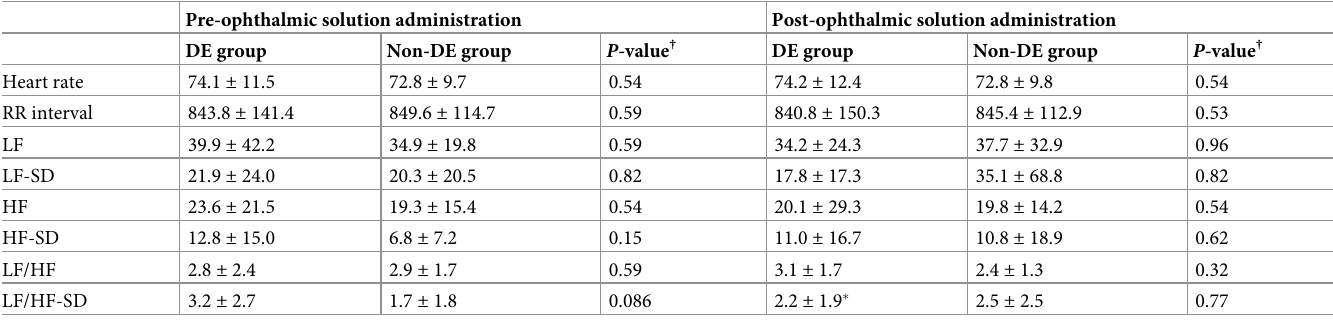
Table 2. Heart rate